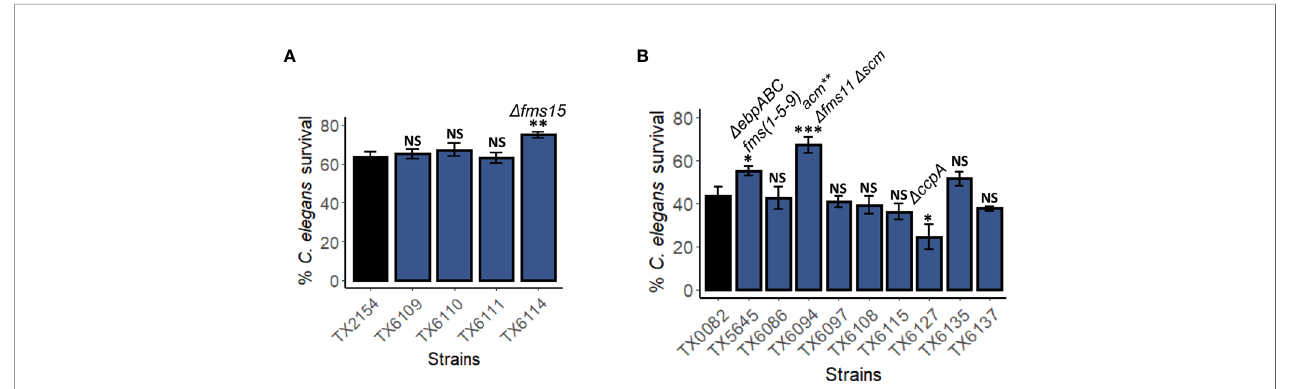
FIGURE 7 | Genes encoding surface proteins and pili are important for pathogenesis in the C. elegans – E. faecium liquid-killing assay. Pathogenicity of several strains harboring mutations in (A) fms10 (scm) , acm , fms18 , or fms15 , or (B) fms , scm , wxl , or ccpA were assayed in the C. elegans – E. faecium liquid-based pathosystem. Three biological replicates with ~400 worms/replicate were analyzed. Error bars represent SEM. p values were determined from Student ’ s t -test. NS not signi fi cant, * p < 0.05, ** p < 0.01, *** p <